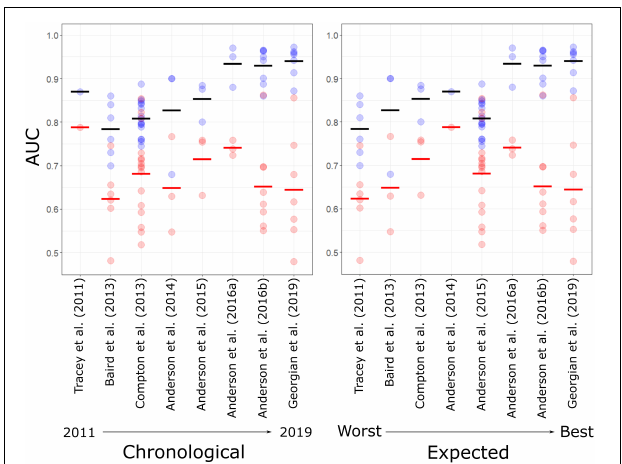
FIGURE 2 | AUC values generated using internal cross-validation (blue) and independent test data (red) for individual habitat suitability models in eight published studies (S1–S8, see Table 1 for details) in order of time of publication from 2011 to 2019 (Left) , and a priori ranking of expected model performance based on the criteria of Araujo et al. (2019) (Right) . Cross bars show mean values for each